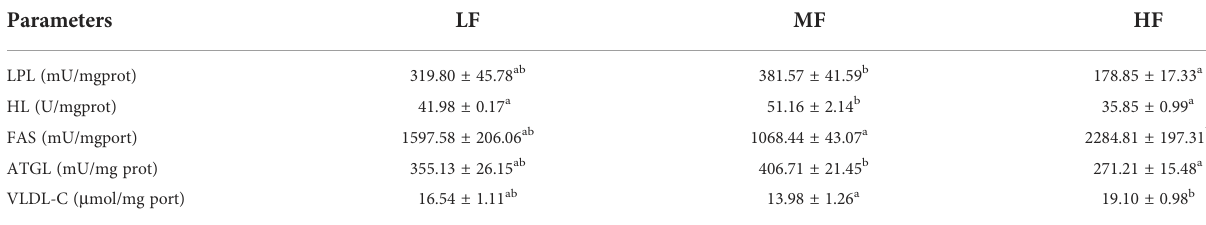
TABLE 9 Effect of dietary lipid levels on lipid metabolism enzymes activity and biochemical indexes in liver of hybrid grouper.